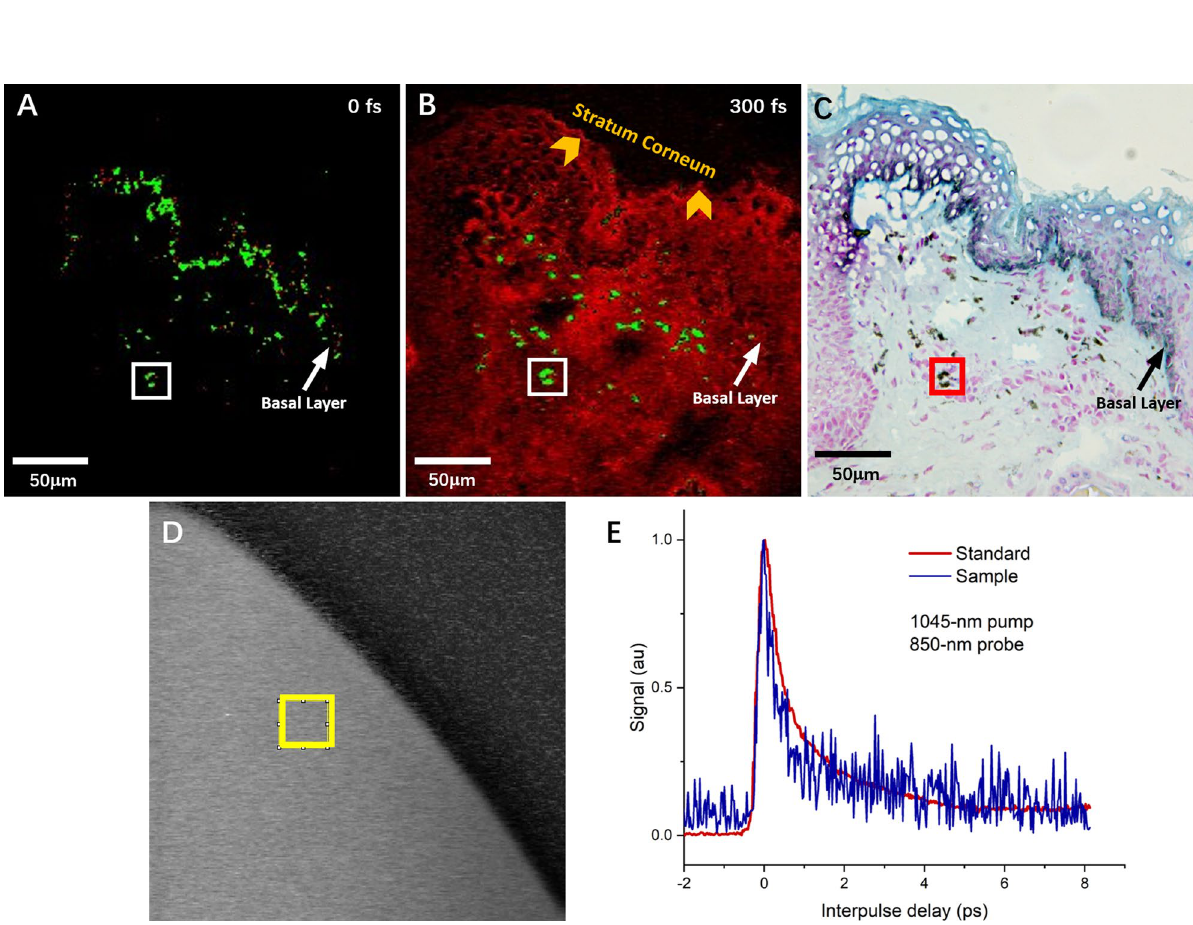
Figure 4. Pump-probe signal and FeSO4 staining of the same field in the lower eyelid skin section of subject 4. ( A ) Pump-probe image with pulse interval 0 fs. ( B ) Pulse interval 300 fs. ( C ) FeSO 4 staining of the same position. ( D ) A target region (yellow box) in the transient absorption signal of pure melanin solution was randomly selected for spectrum analysis. ( E ) Similar pump-probe time delay traces between tissue regions of white boxes in ( A ) and ( B ) with the target region of pure solution melanin (yellow box in D